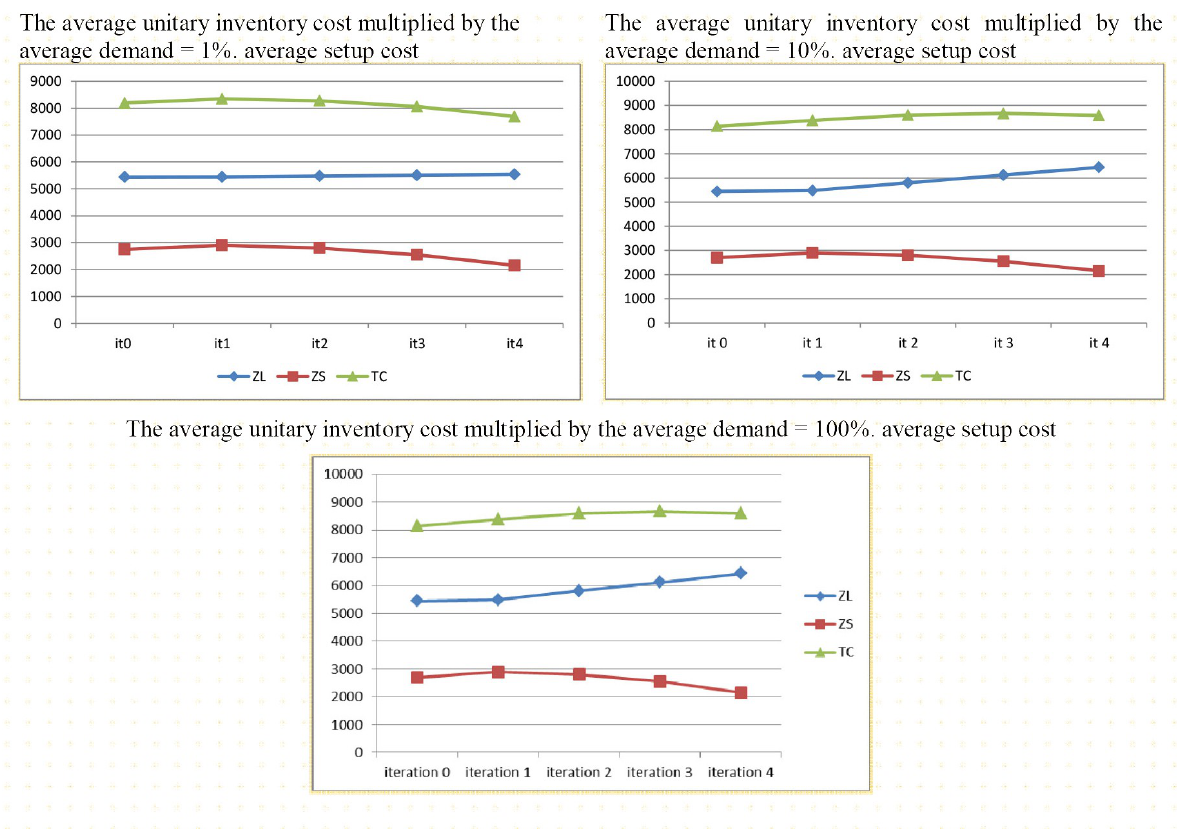
Figure 5. Effect of varying inventory